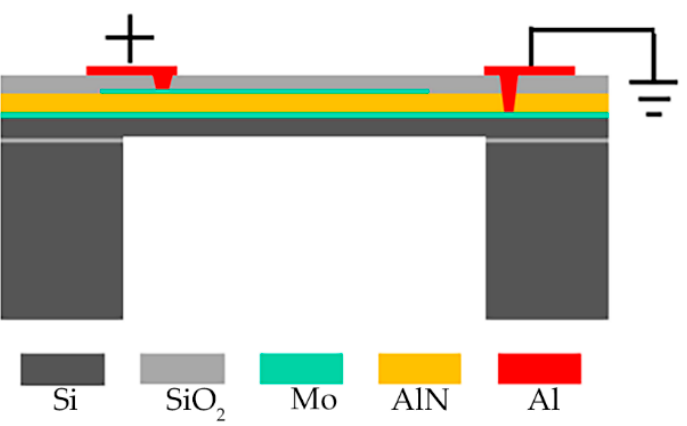
Figure 1. Cross-sectional view of PMUTs.